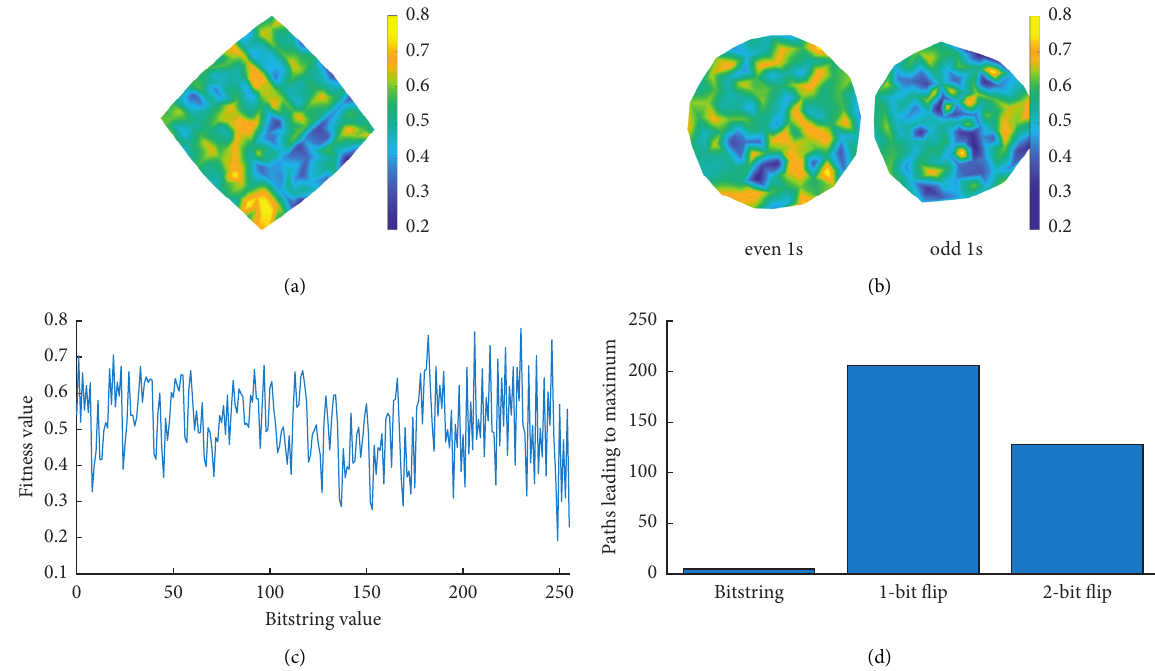
Figure 2: The same function ( N � 8 and K � 3) mapped with three different definitions of the neighborhood. (a) NK landscape visualized by relying on a one-bit flip; i.e., any two solutions are depicted next to each other if the Hamming distance between them is exactly one. (b) NK landscape visualized by relying on a two-bit flip neighborhood structure; i.e., any two solutions are depicted next to each other if the Hamming distance between them is exactly two. The landscape split into two completely disconnected halves since any bitstring with an even number of 1’s can never reach any of the bitstrings with an odd number of 1’s using only two-bit flips; e.g., 0000000 cannot be transformed into 00000001. (c) NK function mapped by converting the bit of strings from a binary number to the decimal number (cf. Østman and Adami [41]) and assuming that solutions are similar if their decimal representation transformations are consecutive; i.e., 10011001 is transformed into 153 and its natural neighbors are 152 (10011000) and 154 (10011010). (d) Comparative performance of (c) bitstring, (a) 1-bit flip, and (b) 2-bit flip